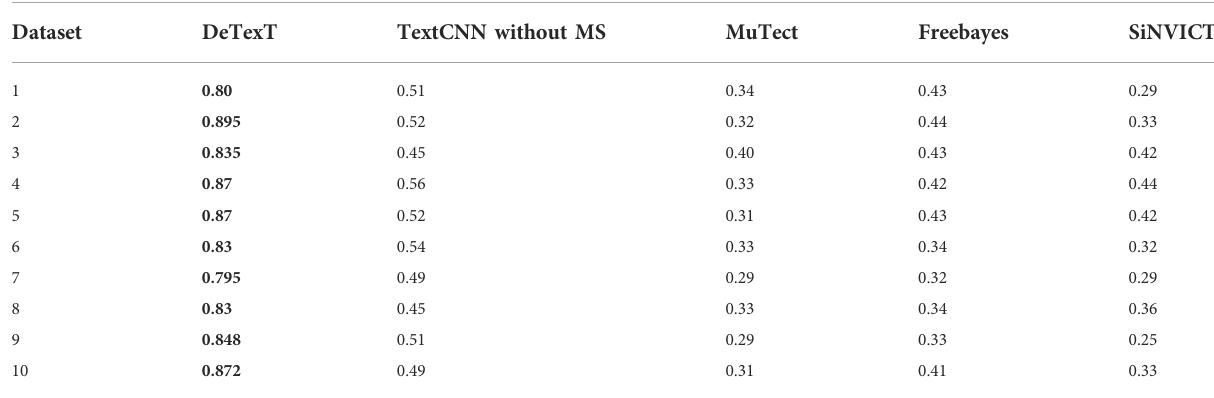
TABLE 3 Comparison result with MuTect, freebayes, and